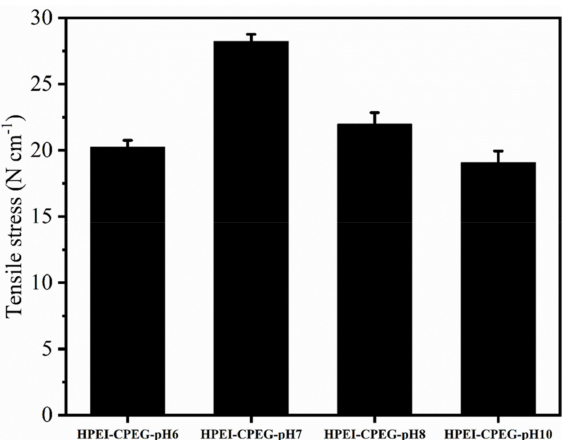
Figure 4. Tensile strength of HPEI-CPEG-pH6, HPEI-CPEG-pH7, HPEI-CPEG-pH8, and HPEI-CPEG- pH10